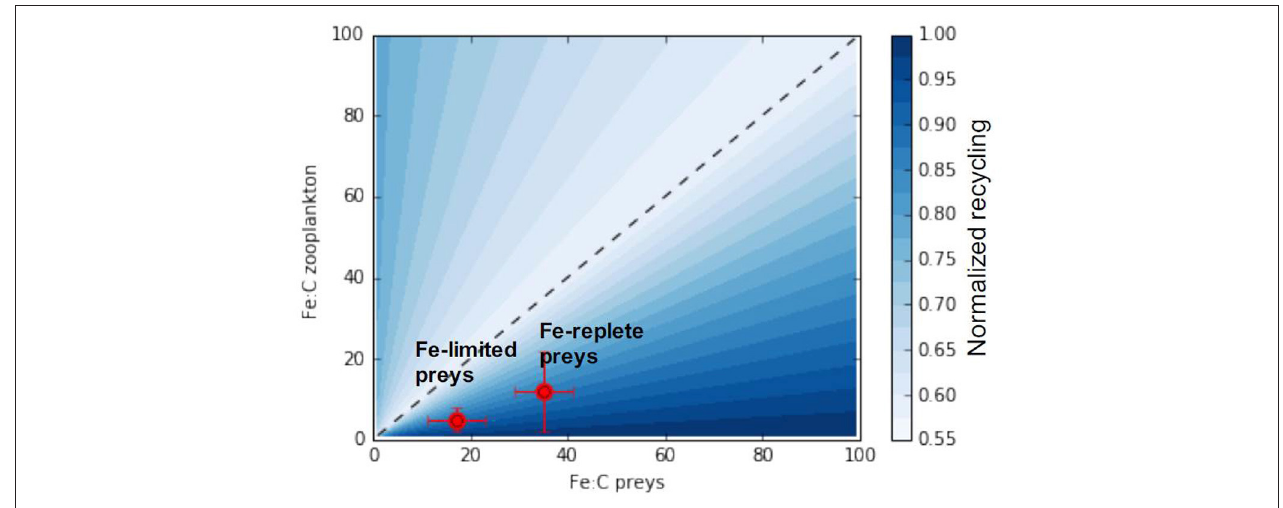
FIGURE 8 | A generic relationship between zooplankton and prey stoichiometries and iron assimilation efficiency. The x and y-axis represent the range of observable zooplankton and prey iron stoichiometries. The black line represents the 1:1 line for which predator and preys stoichiometry are equal. Red points presents the predator prey stoichiometric relationship from the experiments of Schmidt et al.